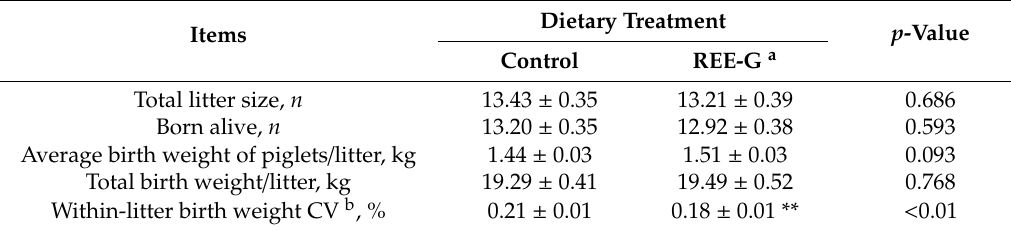
Table 2. E ff ects of rare earth elements (REE) supplementation during late gestation on reproductive performances of the sows at birth.